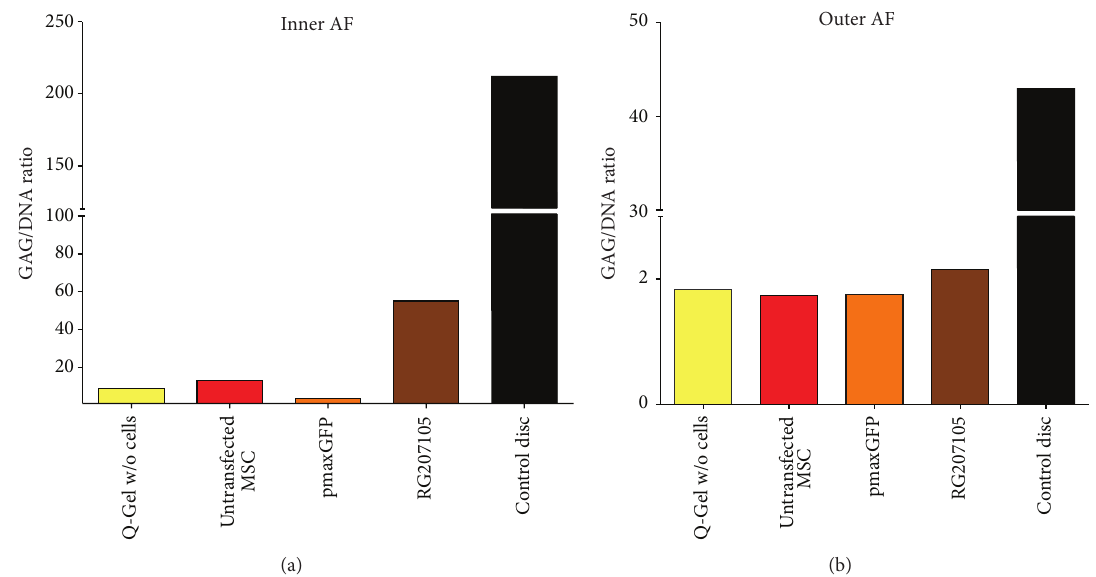
Figure 6: Glycosaminoglycan (GAG)/DNA ratio of outer and inner annulus fibrosus (AF) after 7 days of free-swelling organ culture of bovine intervertebral discs. Please note the difference between untransfected hMSC, control, pmaxGFP, and RG207105 transfected cells. The GDF5 overexpressing cells are pushing partially GAG/DNA ratio back in bovine IVD organ